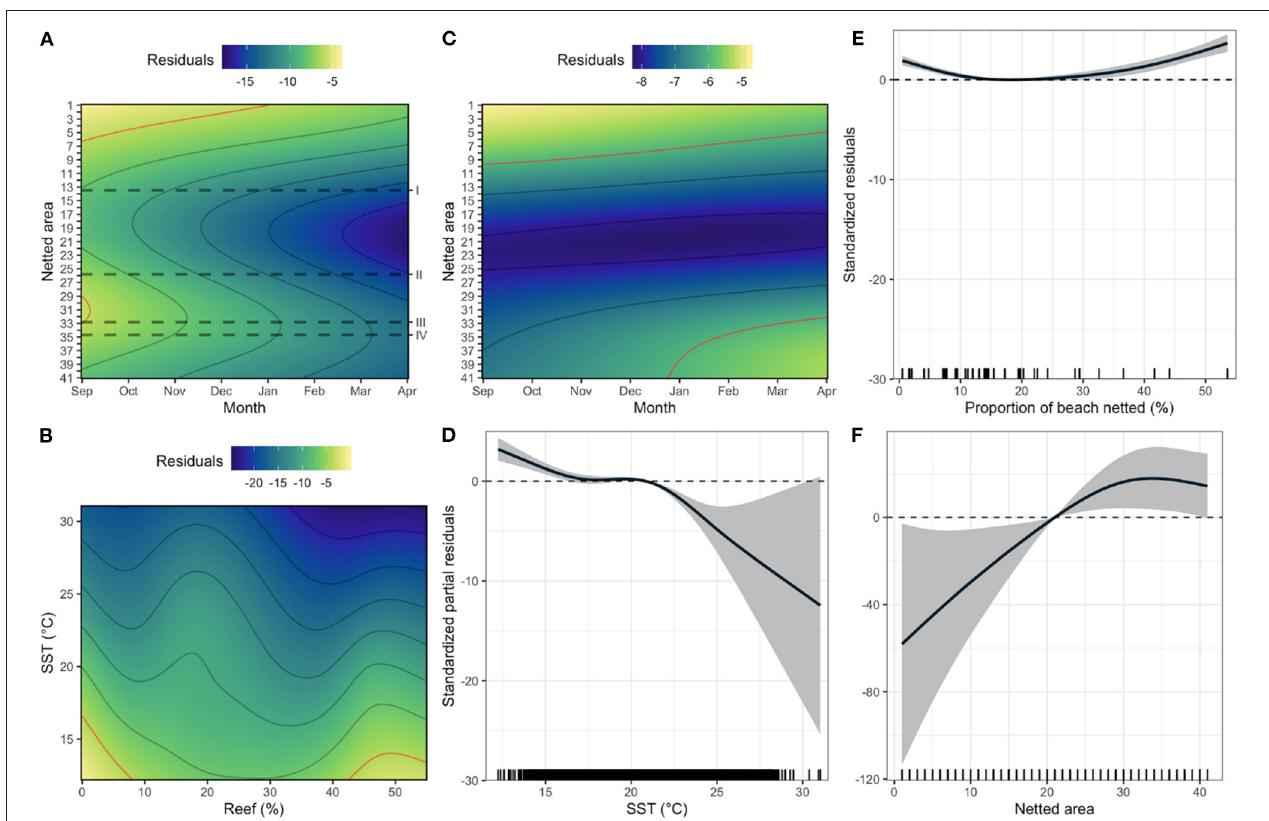
FIGURE 4 | Fine-scale zero-inflated generalised additive models of (A,B) grey nurse, (C–E) white, and (F) tiger shark occurrence in the Shark Meshing Program catches. Spatial-temporal effects of netted area and month (A,C) , and (B) sea surface temperature (SST) and percentage of reef area (Reef), and the individual effects of (D) SST, (E) proportion of beach netted, and (F) netted area. Colour scales, shaded areas and solid and dashed lines (D–F) , respectively, represent the respective model residuals, the 95% confidence intervals, the raw data and the null effects. The red isolines (A–C) represent the highest residual contours for the corresponding models. Dashed lines (A) depict the grey nurse shark aggregation sites (I = Foggies, II = Long Reef, III = Magic Point, IV = South Marley).